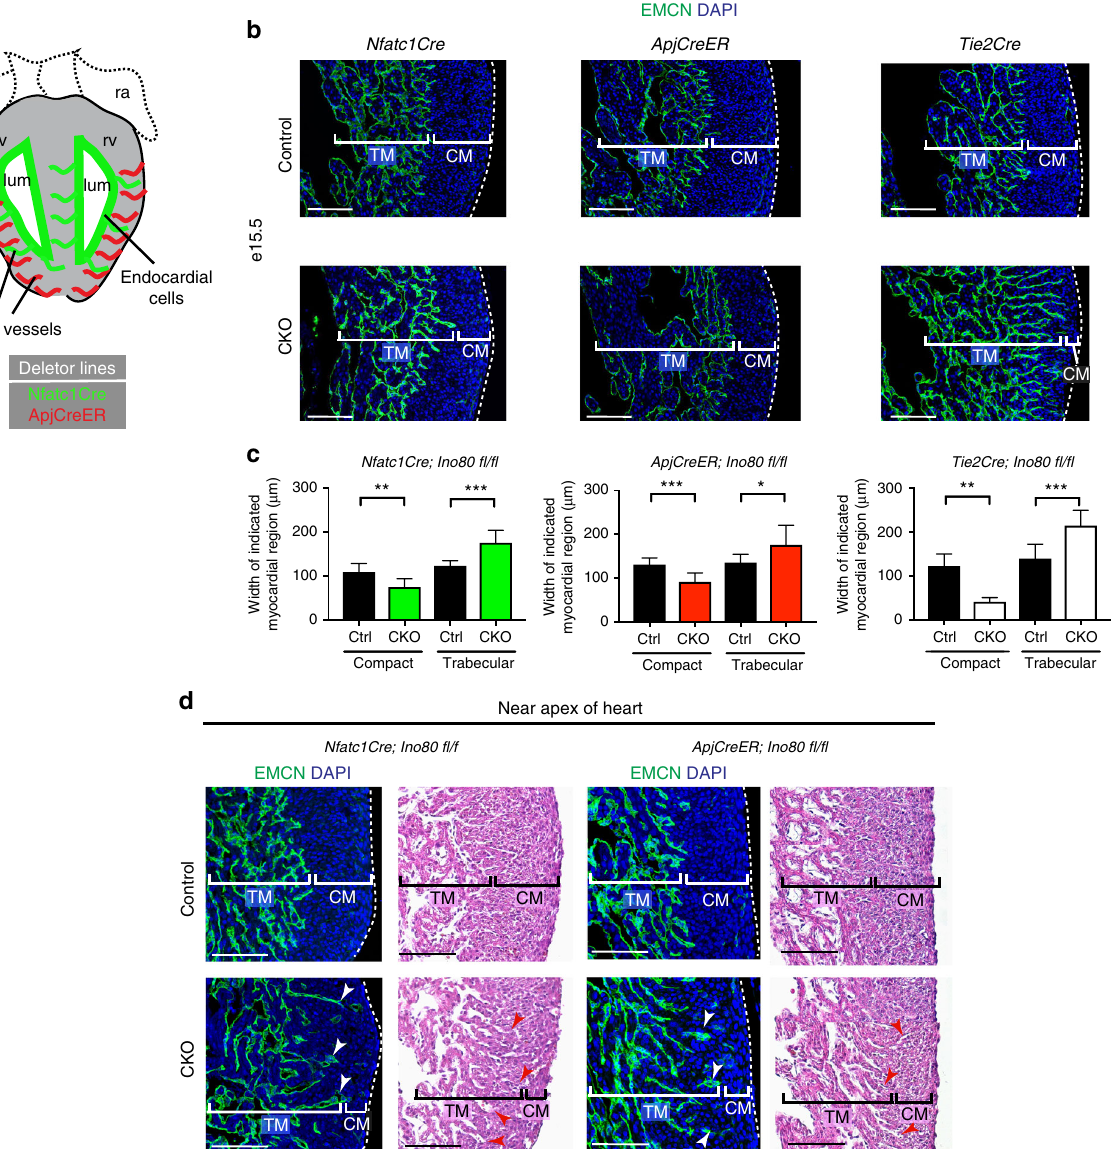
Fig. 3 Deletion of Ino80 using sinus venosus- or endocardial-speci fi c Cre lines. a Schematic section through the heart showing the two types of endothelial cells within the heart and the Cre lines that differentially label each subset. b Endomucin (endocardial cells) and DAPI (nuclei) immuno fl uorescence in e15.5 hearts highlights reduction of compact myocardial thickness in hearts where Ino80 was deleted using either Nfatc1Cre , ApjCreER , or Tie2Cre . Images are representative of the following number of replicates: Nfatc1Cre (control, n = 9 hearts; mutant, n = 6 hearts), ApjCreER (control, n = 12 hearts; mutant, n = 4 hearts), or Tie2Cre (control, n = 9 hearts; mutant, n = 6 hearts). Conditional knockouts are labeled CKO. Scale bars: 100 μ m. c Quanti fi cation of compact and trabecular myocardial thickness in each condition. Error bars in graphs are standard deviation. Nfatc1Cre (control, n = 9 hearts; mutant, n = 6 hearts), ApjCreER (control, n = 12 hearts; mutant, n = 4 hearts), or Tie2Cre (control, n = 9 hearts; mutant, n = 6 hearts). * P < 0.05; ** P < 0.01; *** P < 0.001, evaluated by Student ’ s t -test. d Example of abnormal extensions of Endomucin-positive endocardial cells (arrowheads) into the compact layer in CKO embryos. H&E sections are of comparable regions of the apex. Images are representative of the following number of replicates: Nfatc1Cre (control, n = 9 hearts; mutant, n = 6 hearts), ApjCreER (control, n = 12 hearts; mutant, n = 4 hearts). Scale bars: 100 μ